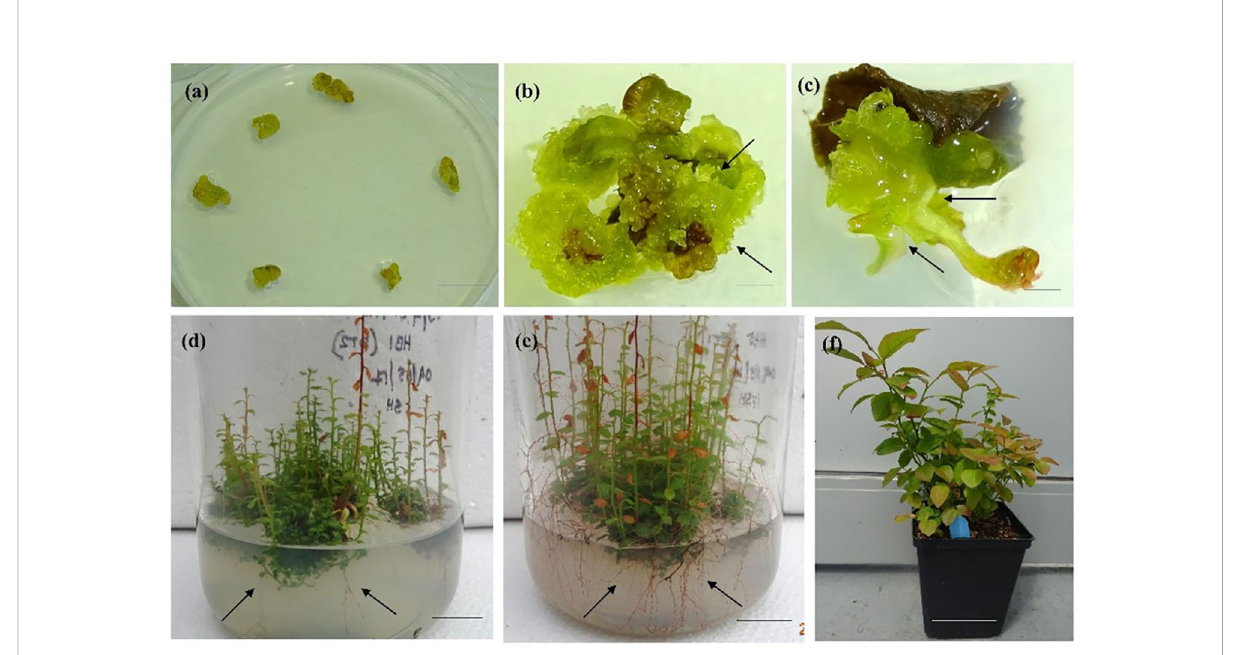
FIGURE 2 In vitro propagation via somatic embryogenesis in half-high blueberry cv. “ Northblue ” . (A) Young leaf cultured on a medium with 9 µM TDZ, (B) globular embryo development (arrows) after 4 weeks of culture in a 9 µM TDZ-supplemented medium, (C) germination of somatic embryos and shoot and root apex development (arrow) after 10 weeks of culture with 9 µM TDZ (scale bar = 0.5 cm), (D) root elongation (arrows) in a nutrient medium containing 2.3 µM TDZ, after 4 weeks of culture in a glass jar (scale bar = 2 cm), (E) development of rooting system (arrows) in a nutrient medium with 2.3 µM TDZ after 6 weeks of culture in a glass jar (scale bar = 2 cm), and (F) 1-year-old hardened-off plants in a greenhouse (scale bar = 5